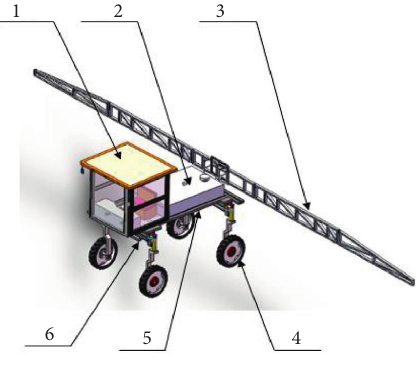
Figure 1: Overall 3D model. Table 1: Main parameters of Adams overall simulation.